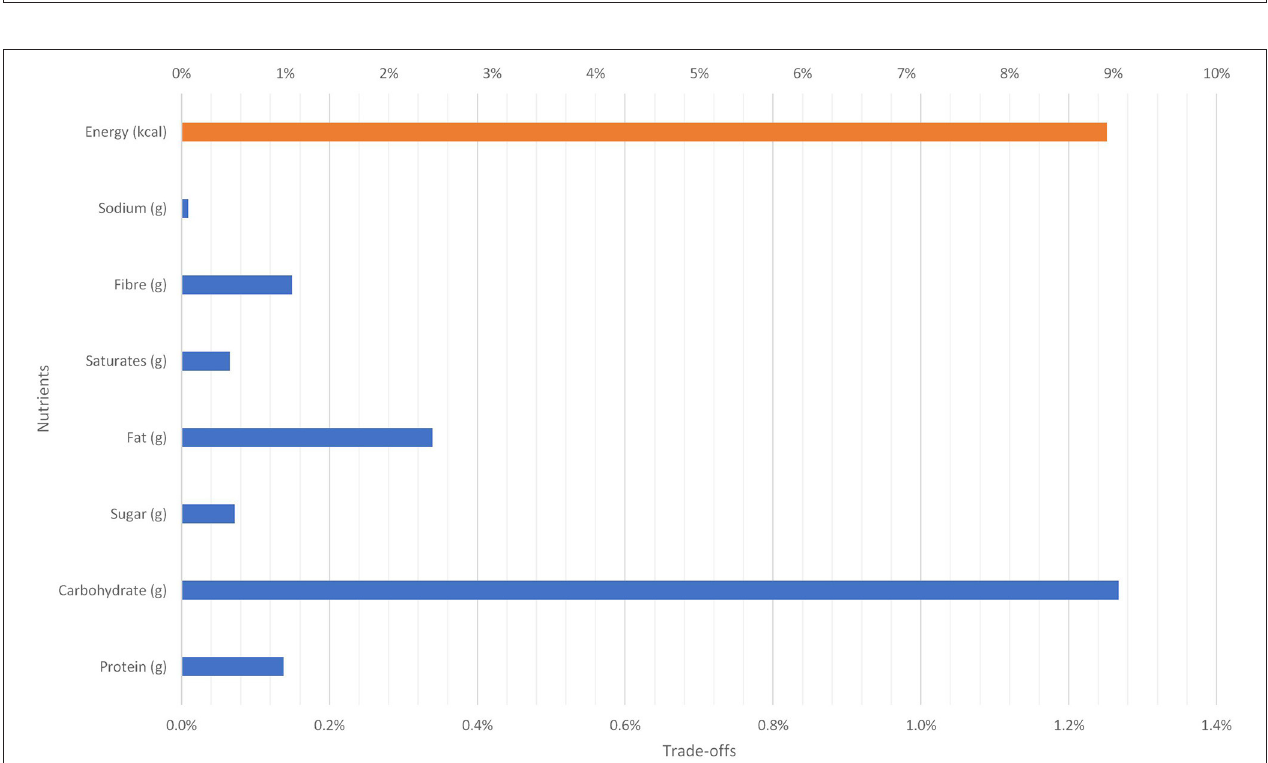
FIGURE 11 | Nutritional trade-off due to 10% reduction in the price of frozen chips and other processed potatoes on new potatoes baby.